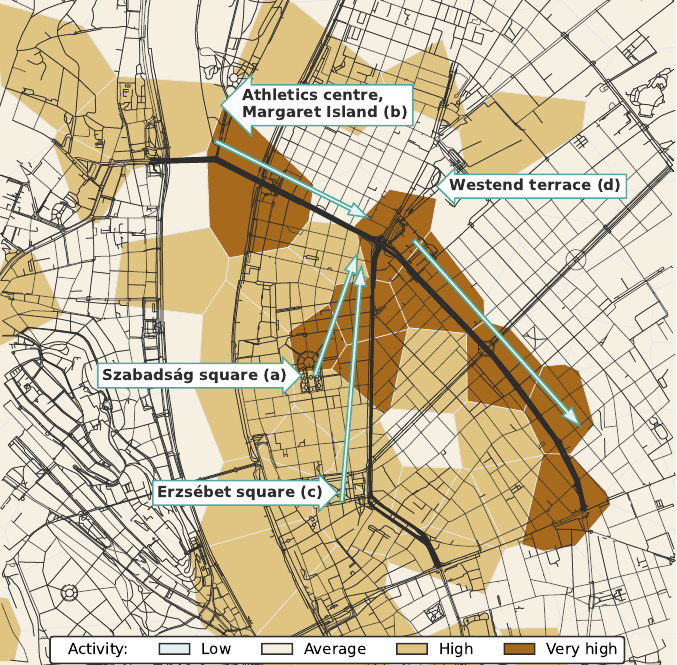
Figure 12. After the Hungary vs. Portugal football match, the fans, delirious with joy, filled the streets. The arrows show their route from the main fan zones to and along the Grand Boulevard. Voronoi polygons colored by the mobile phone network activity at the peak of the event at